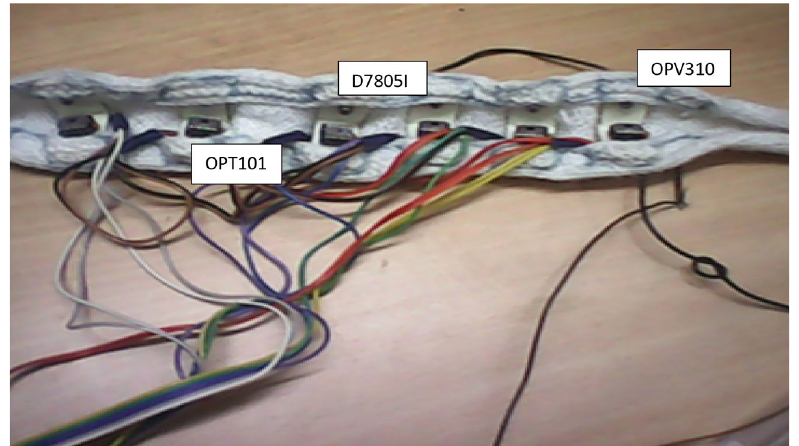
Figure 2. Laser sources and